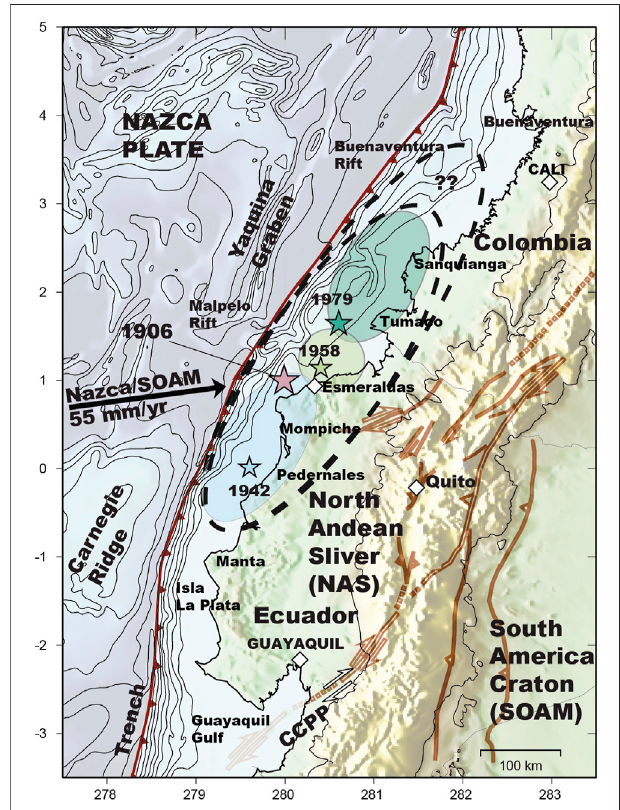
FIGURE 1 | Seismotectonic setting of the Ecuador – Colombia subduction zone where the Nazca plate subducts below the North Andean Sliver (NAS) and the South America Craton (SOAM). The Carnegie Ridge and the Yaquina Graben are the two main geomorphological features on the oceanic sea fl oor. The Yaquina graben is an abandoned transform fault that behaves as a fracture zone that contributes to the reactivation of normal faults associated with paleo-rifts as the Malpelo rift and the Buenaventura rift that intersects the trench at 3.5 ° N (Lonsdale, 2005; MacMillan et al., 2004; Yepes et al., 2016) (see also Supplementary Figure S1 ). At the Colombia – Ecuador border, the relative Nazca/SOAM plate convergence rate is about 55 mm/yr (Kendrick et al., 2003). This oblique convergence is partitioned between quasi-normal motion accommodated on the subduction megathrust interface at the trench axis and right-lateral transpressional strike-slip motion on the Chingual-Cosanga-Pallatanga-Puná (CCPP) fault system (Alvarado et al., 2016; Yepes et al., 2016). The ellipses indicate the rupture and aftershocks areas with associated epicenters (stars) of the great 1906 Mw (cid:1) 8.6 (black dashed lines), of the 1942 Mw (cid:1) 7.8 (light blue), of the 1958 Mw (cid:1) 7.6 (light green), and of the 1979 Mw (cid:1) 8.1 (green) megathrust earthquakes (Beck